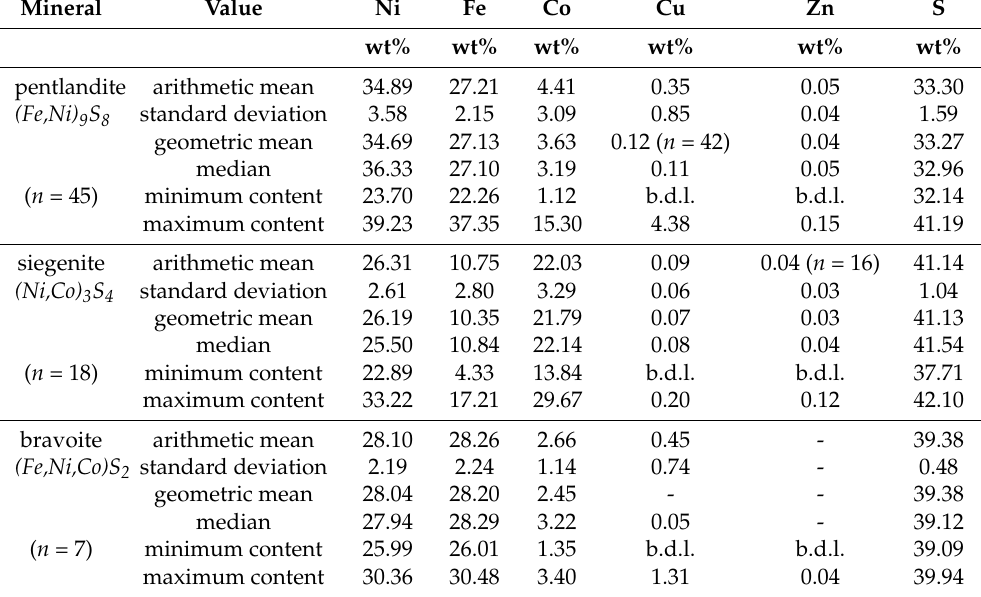
Table 4. The basic statistical parameters of the chemical composition of pentlandite, siegenite, and bravoite from the Krzemianka and Udryn Fe-Ti-V